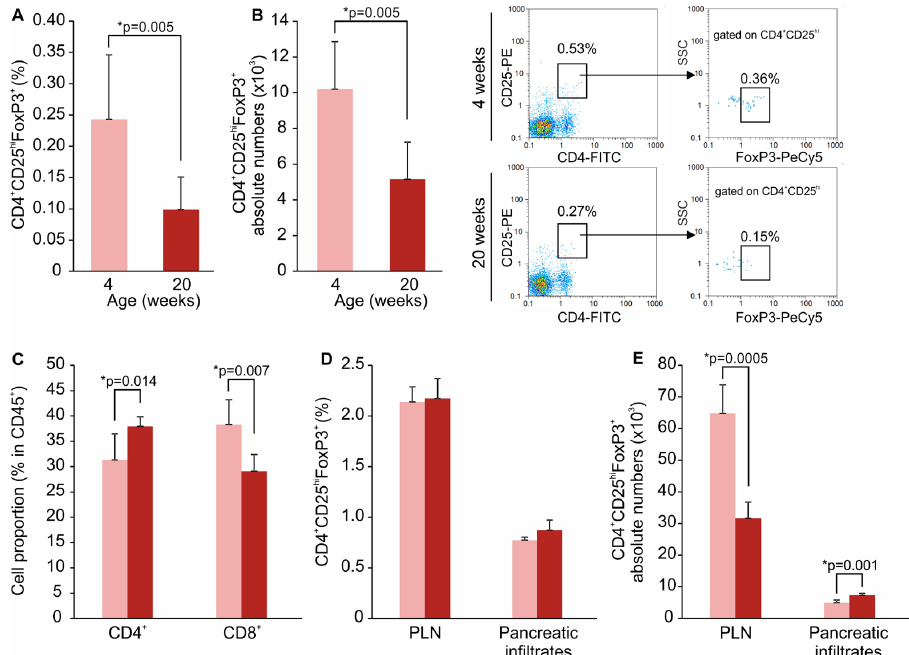
Figure 2. Mature NOD mice exhibit lower Treg proportions in the SILP. The percentages of CD4 + CD25 hi FoxP3 + Treg ( A ) and their absolute numbers ( B ) in the SILP of prediabetic (4-weeks-old) and diabetic (20-weeks-old) NOD mice. Representative dot plots are shown. Frequencies of CD4 + and CD8 + T cells in the SILP ( C ). Treg proportions ( D ) and absolute numbers ( E ) in the pancreatic lymph nodes (PLN) and pancreatic infiltrates. Number of mice per group was 6. * p < 0.05 was considered as statistically significant when samples from mature and young mice were compared.